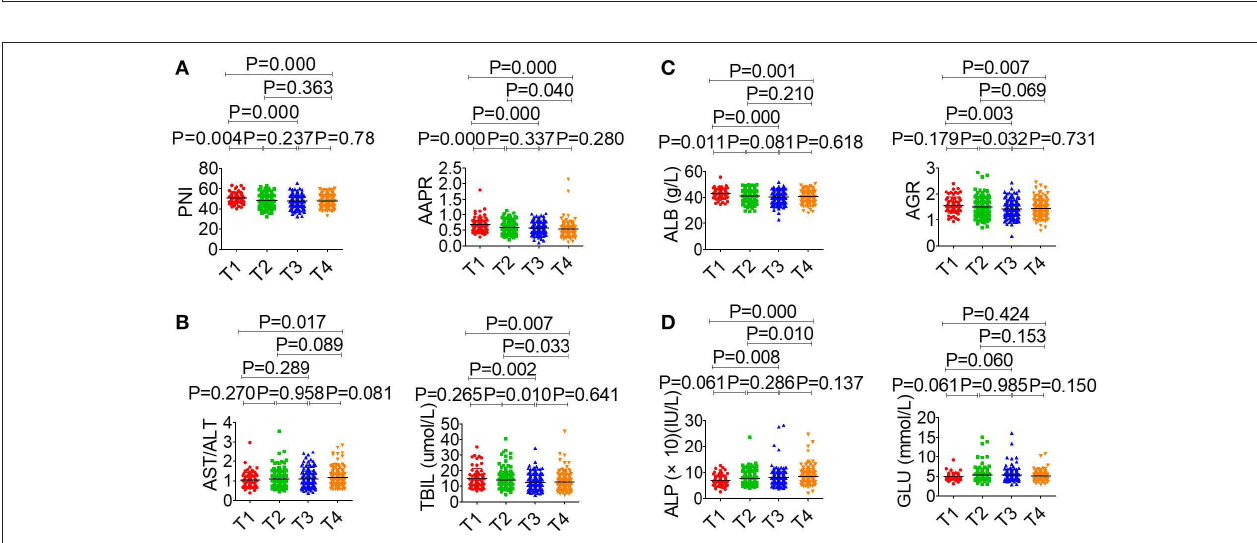
FIGURE 4 | Effects of T stage on serological parameter. (A) PNI (left), AAPR (right). (B) AST/ALT (left), TBIL (right). (C) ALB (left), AGR (right). (D) ALP (left), GLU (right).